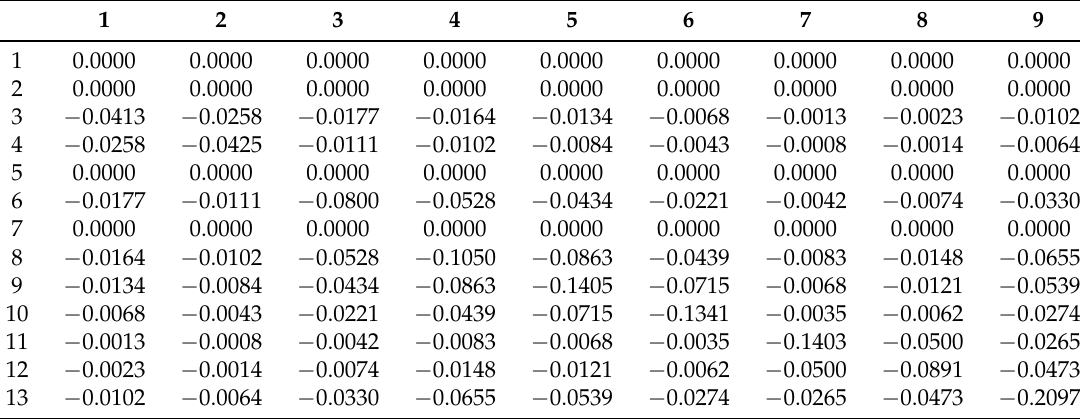
Table 4. Matrix B v T in a 14 buses system.